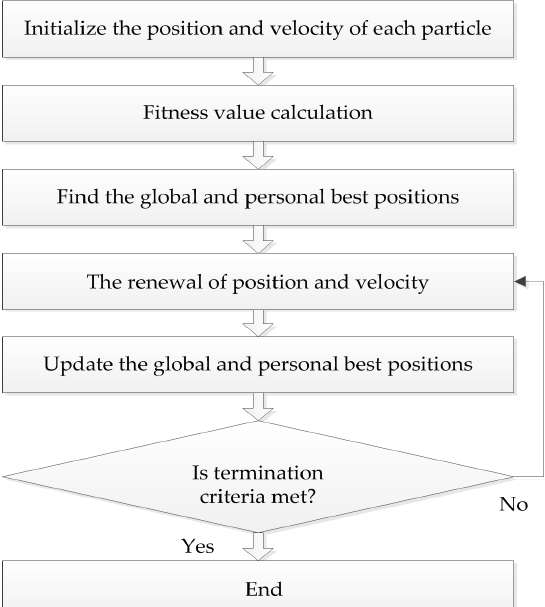
Figure 2. The flowchart of PSO algorithm.